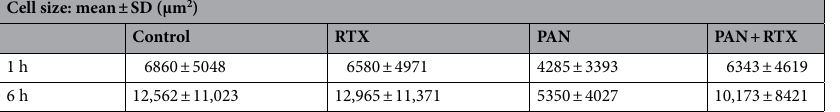
Table 4. Rituximab induces an increased spreading of human podocytes after post-plating. Quantification of cell size at 1 and 6 h after post plating. RTX = rituximab (100 µg/ml); PAN = puromycin aminonucleoside (30 µg/ml). Treatment time: 48 h; n = 4 experiments; ≥ 300 cells per condition. Data are means (%) ± SD.